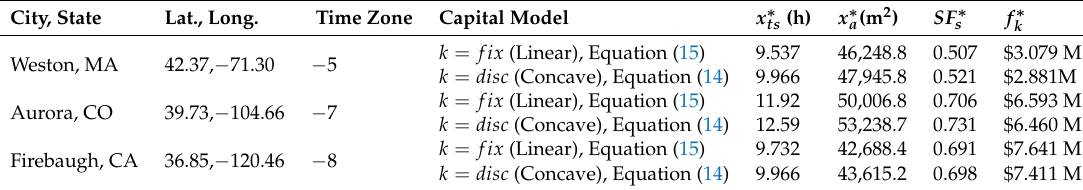
Table 2. The optimal solar-IPH hybridization strategies for the three geographic locations for periodic IPH demand with ¯ q p = 10 5 kW and σ p = 0.1 for the commercial fuel rate. The global optimal results for the concave capital cost model in Equation (14) are included for comparison against the linear capital cost model in Equation (15).